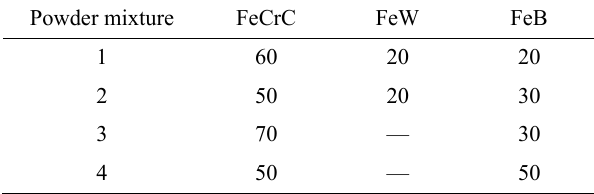
Table 2 Mixing ratios of the surface coating powders.